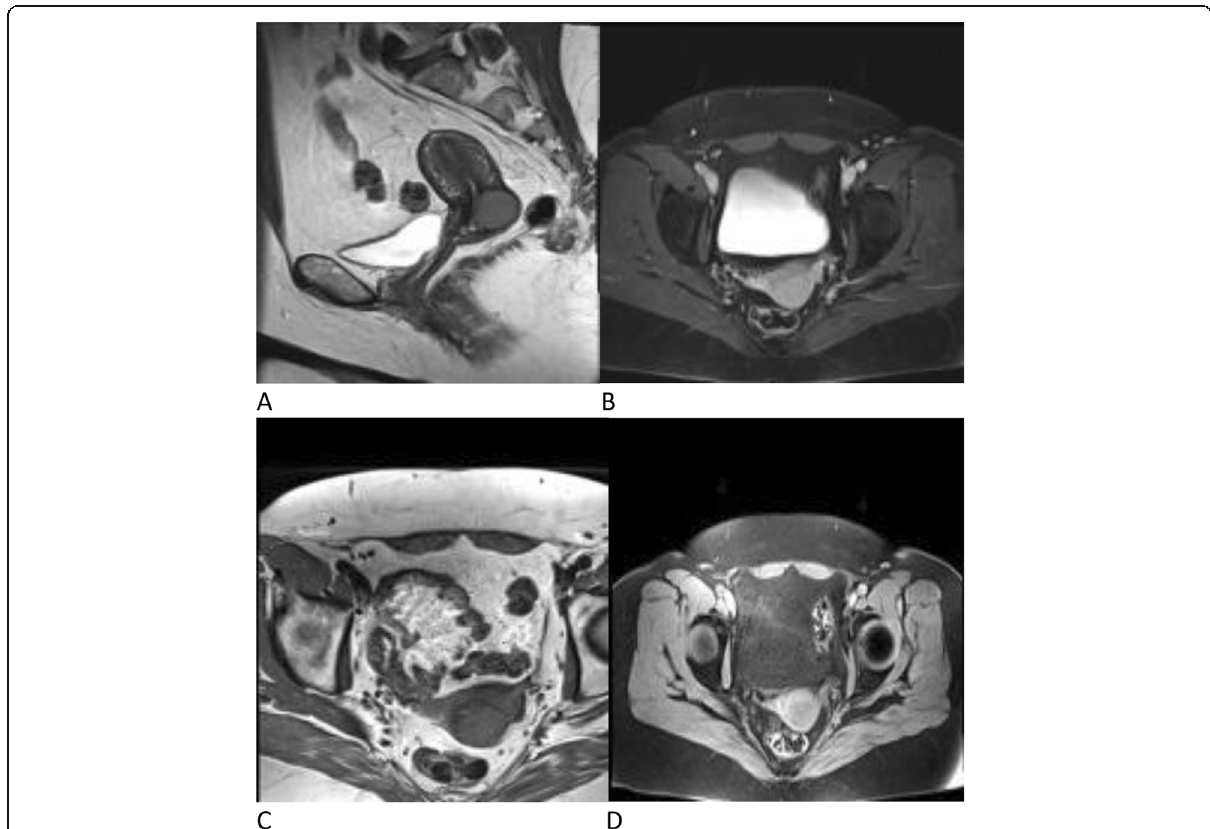
Fig. 3 A 42-year-old female patient presented with vaginal bleeding. MRI pelvis was done. a , b Sagittal and axial T2WI revealed a homogenously isointense abnormal signal intensity focal lesion with a well-circumscribed margin seen involving the posterior wall of the uterine cervix mildly encroaching upon the endocervical canal. c Axial T1WI, the lesion showed no areas of hemorrhage or degeneration. d Late post-contrast T1WI, the lesion showed homogenous contrast enhancement. Diagnosis: benign cervical lesion mostly cervical fibroid (myoma)